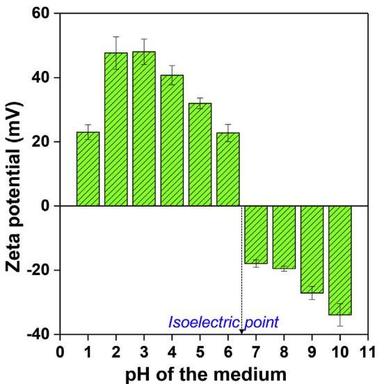
Zeta potential of mesoporous alumina at different pH.